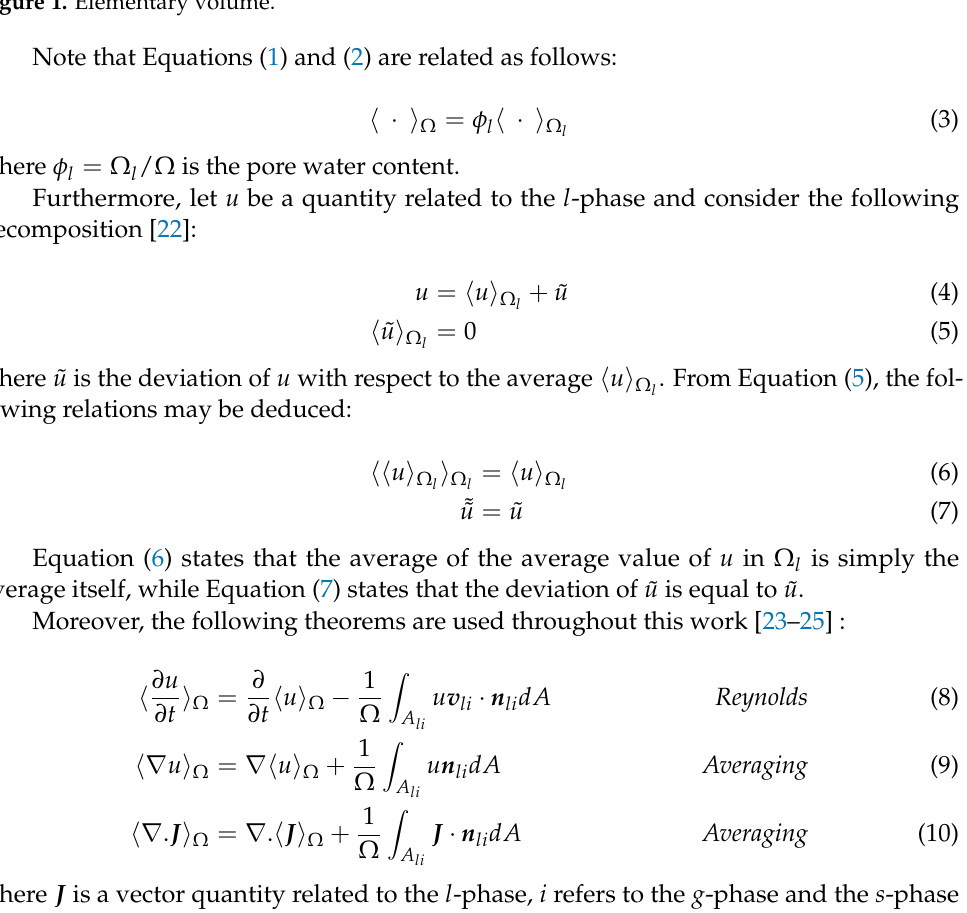
Figure 1. Elementary